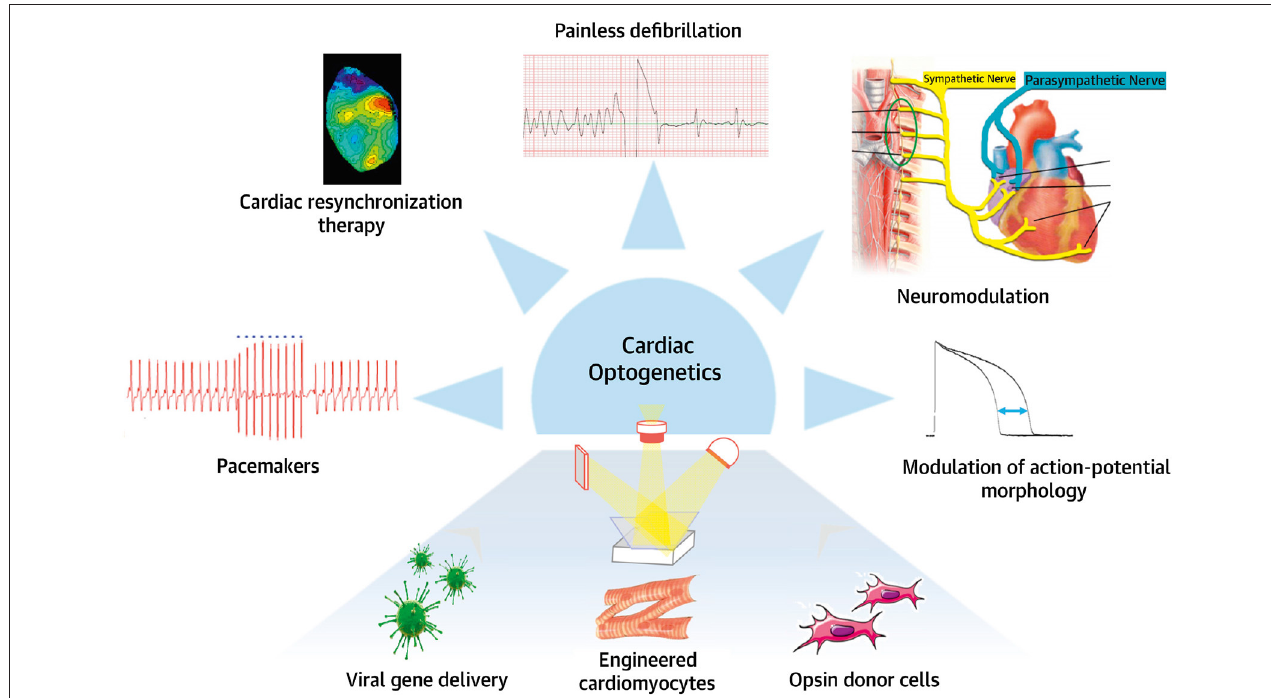
FIGURE 14 | Potential applications of optogenetics. Potential clinical use of cardiac and neuronal optogenetics for heart rhythm control in neuromodulation, pacemaker, or/and anti-arrhythmic applications. Modified with permission from Gepstein and Gruber